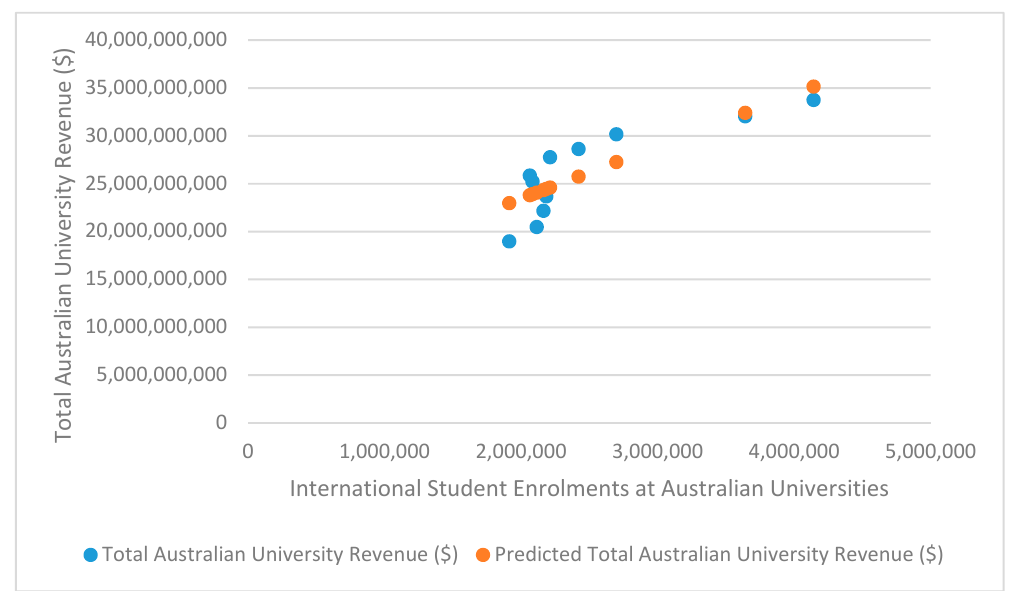
Figure 5. Line Fit Plot for FTE Employment and Total Australian University Revenue. Based on our data for our three key variables in Table 2, we produced a correlation matrix which can be seen in Table 3. Table 3 highlights that there is a linear relationship between total Australian university revenue and FTE employment positions at Australian universities. This is informed by the positive correlation coefficient of 0.989416939 between these two variables. Similarly, we show that there is a positive linear relationship between total Australian university revenue and the number of international student enrolments at Australian universities, as highlighted by the correlation coefficient of 0.831864998. The p -value in Table 3 determines whether the relationship between the dependent variable and independent variables are statistically significant and as such can be used to test our hypotheses.